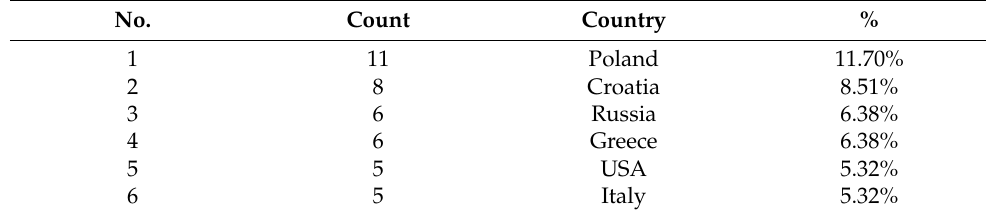
Table 4. Top countries by the number of conference papers.